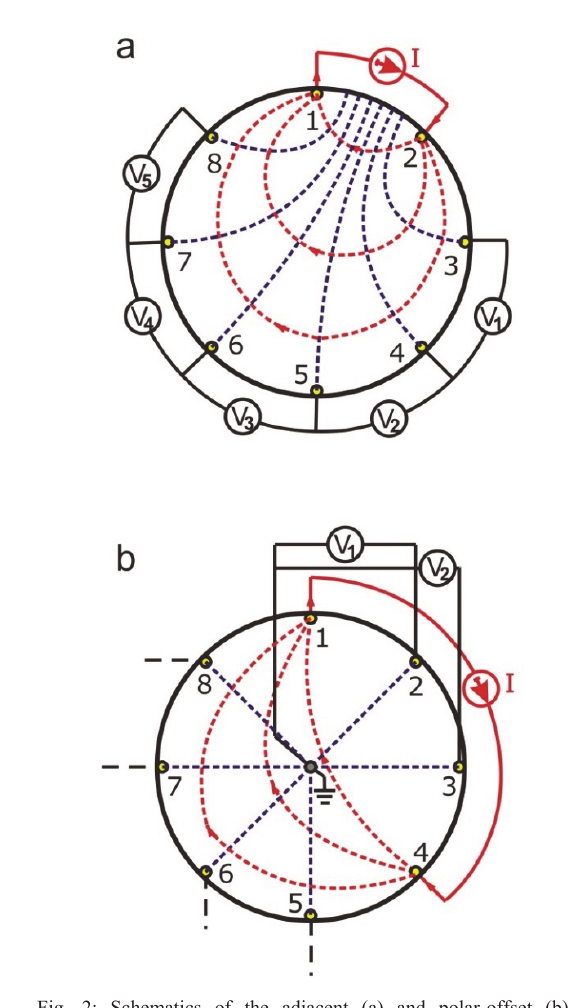
Fig. 2: Schematics of the adjacent (a) and polar-offset (b) configurations. Red and blue dashed lines represent the directions of CC and PU electric fields, respectively. A detailed description of the configurations is given in Supplementary Material